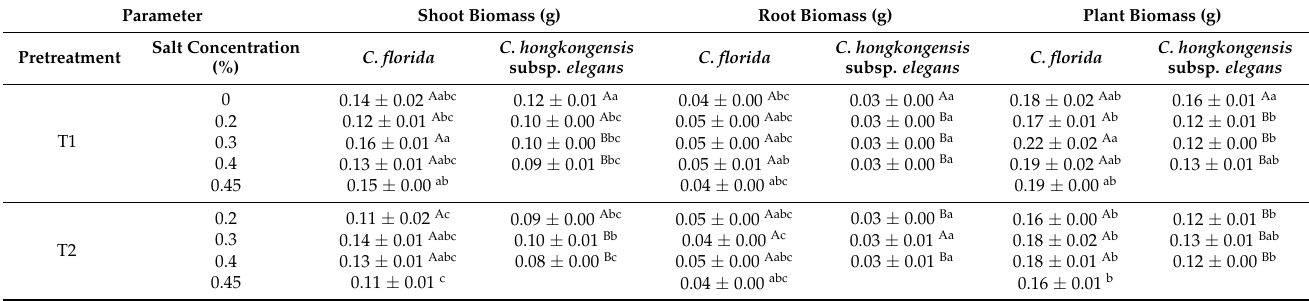
Table 3. Effects of different treatments on the biomass (dry weight) of shoot, root, and plant of C. florida and C. hongkongensis subsp. elegans